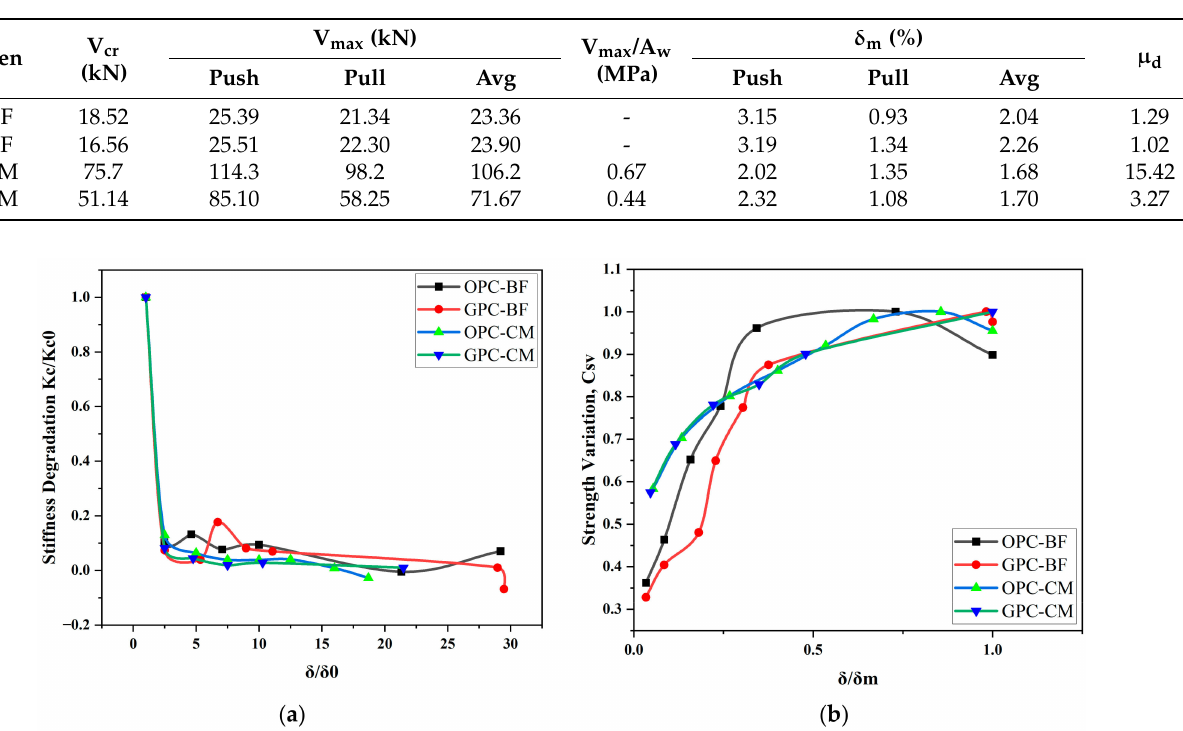
Figure 10. ( a ) Stiffness degradation ( b ) Strength